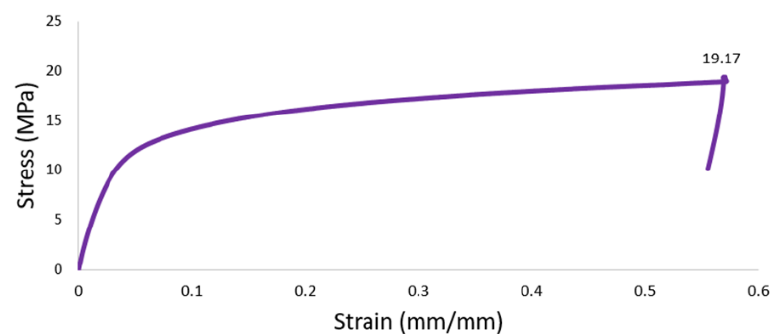
Figure 9. Stress–strain of additively manufactured nylon.